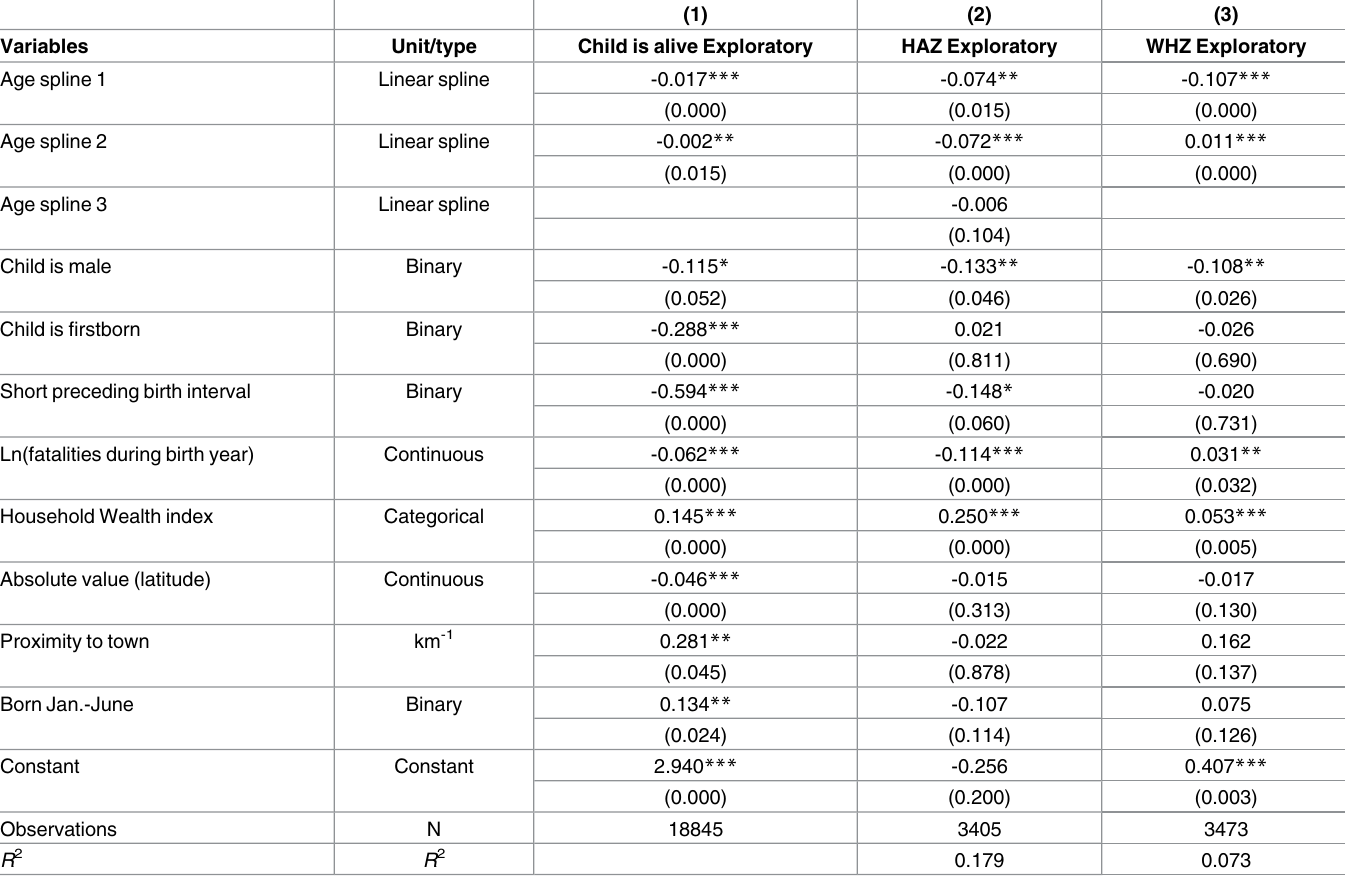
Table 4. Exploratory regressions with continuous explanatory